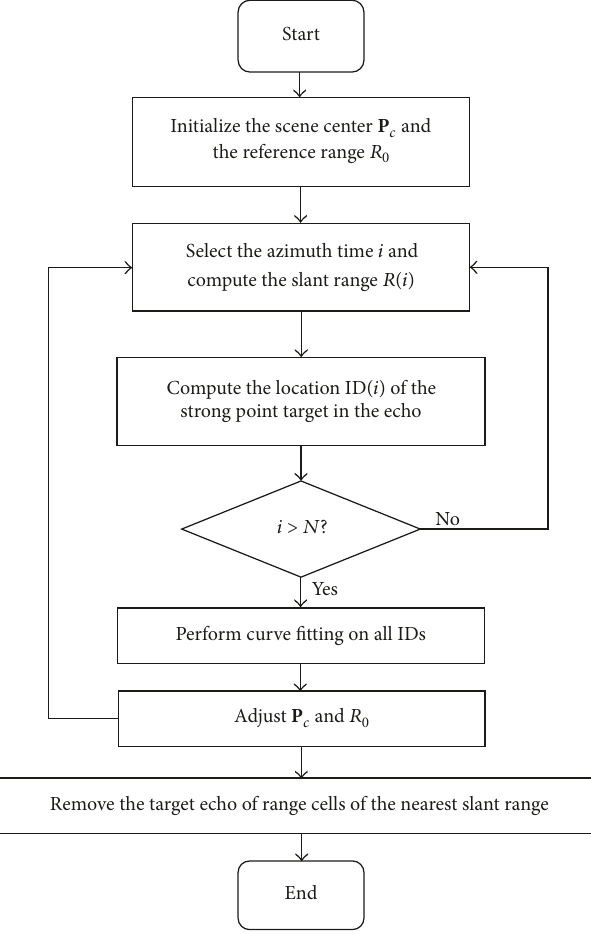
Figure 3: The flow chart of the proposed method, where 𝑁 is the total azimuth